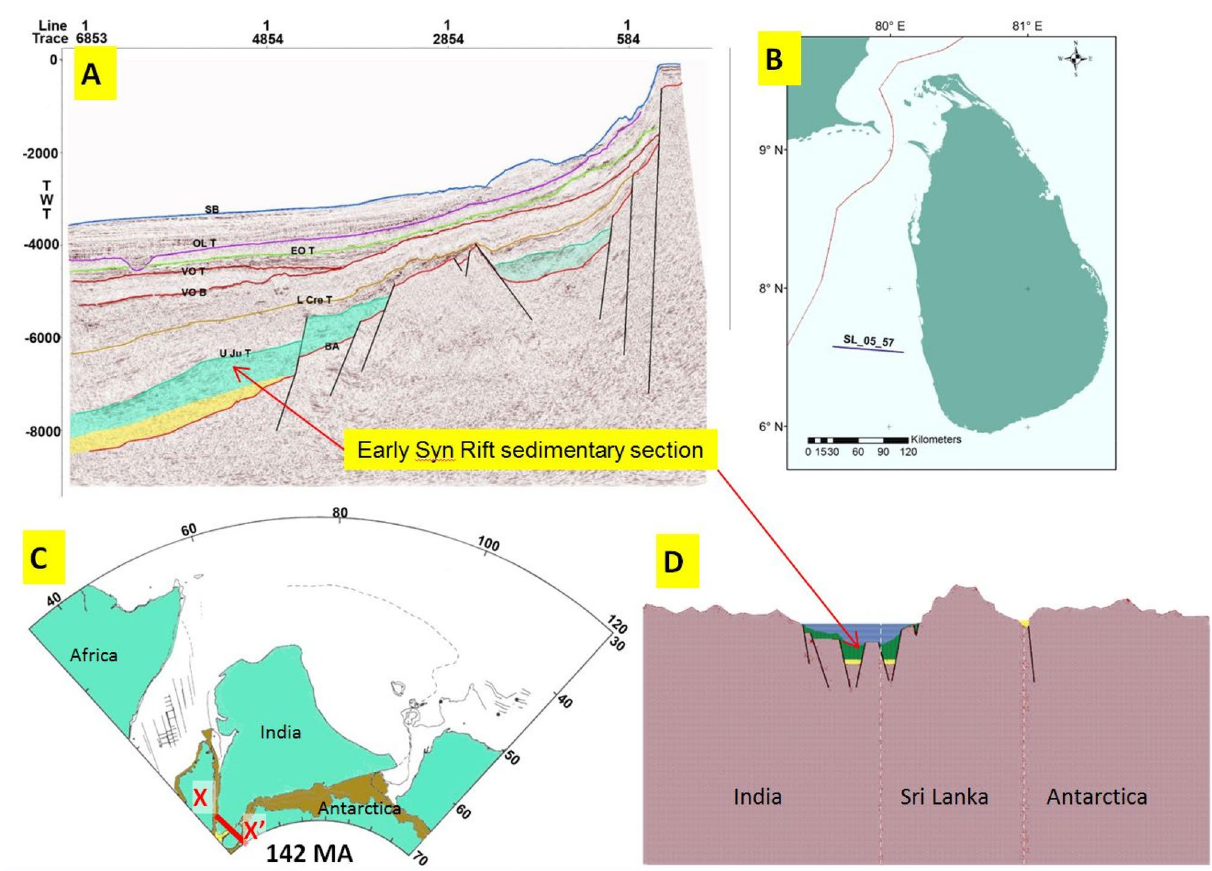
Fig. 6 a Seismic line SL-05-57 depicting the early syn-rift sediments below the top Upper Jurassic (U Ju T) horizon. b A base map show- ing the location of line SL-05-57. c Plate tectonic reconstruction at 142 Ma representing the end of the early syn-rift phase and the con- figuration of the east Gondwanaland and opening of the